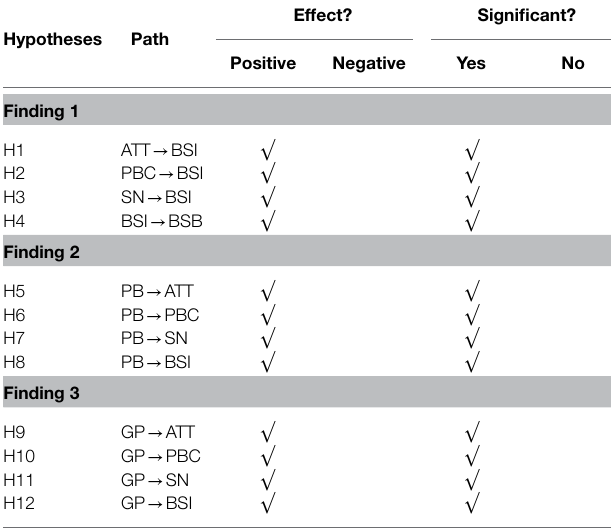
TABLE 6 | Summary of the empirical results.